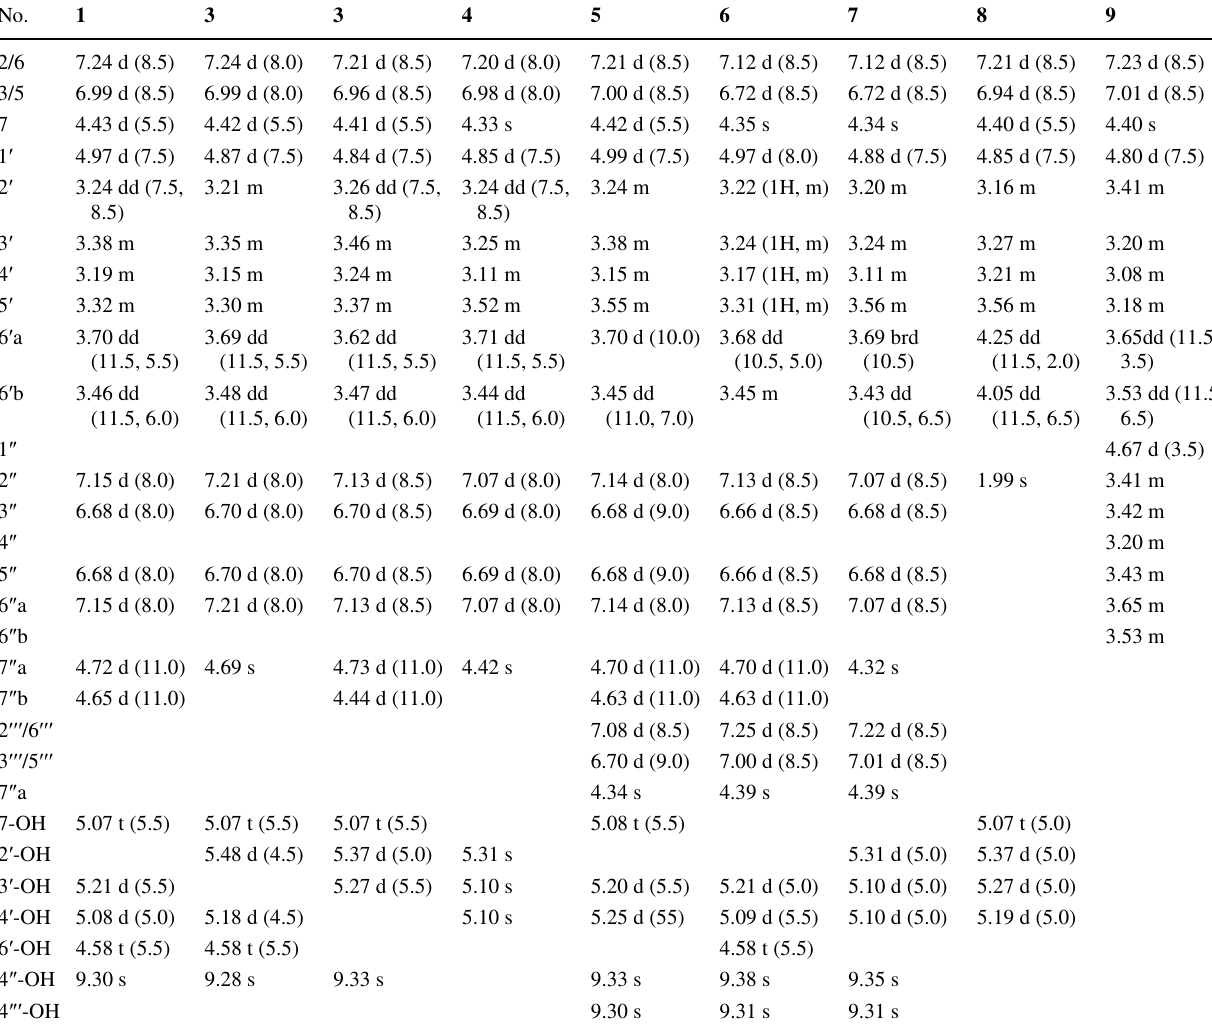
Table 1 NMR spectral data ( δ ) for compounds 1 – 9 a